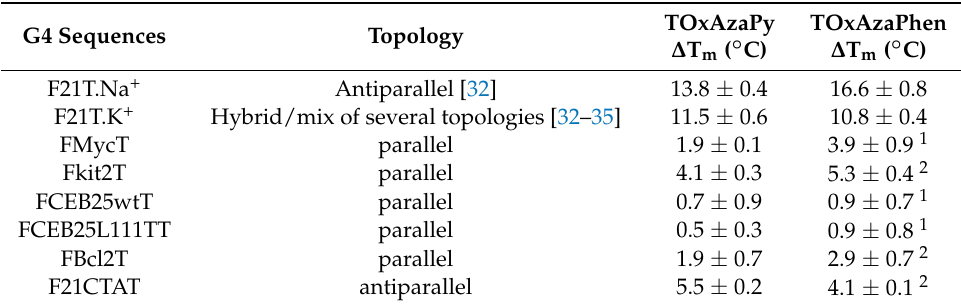
Table 3. ∆ T m values for 6 and 7 (1 µ M) towards several G4